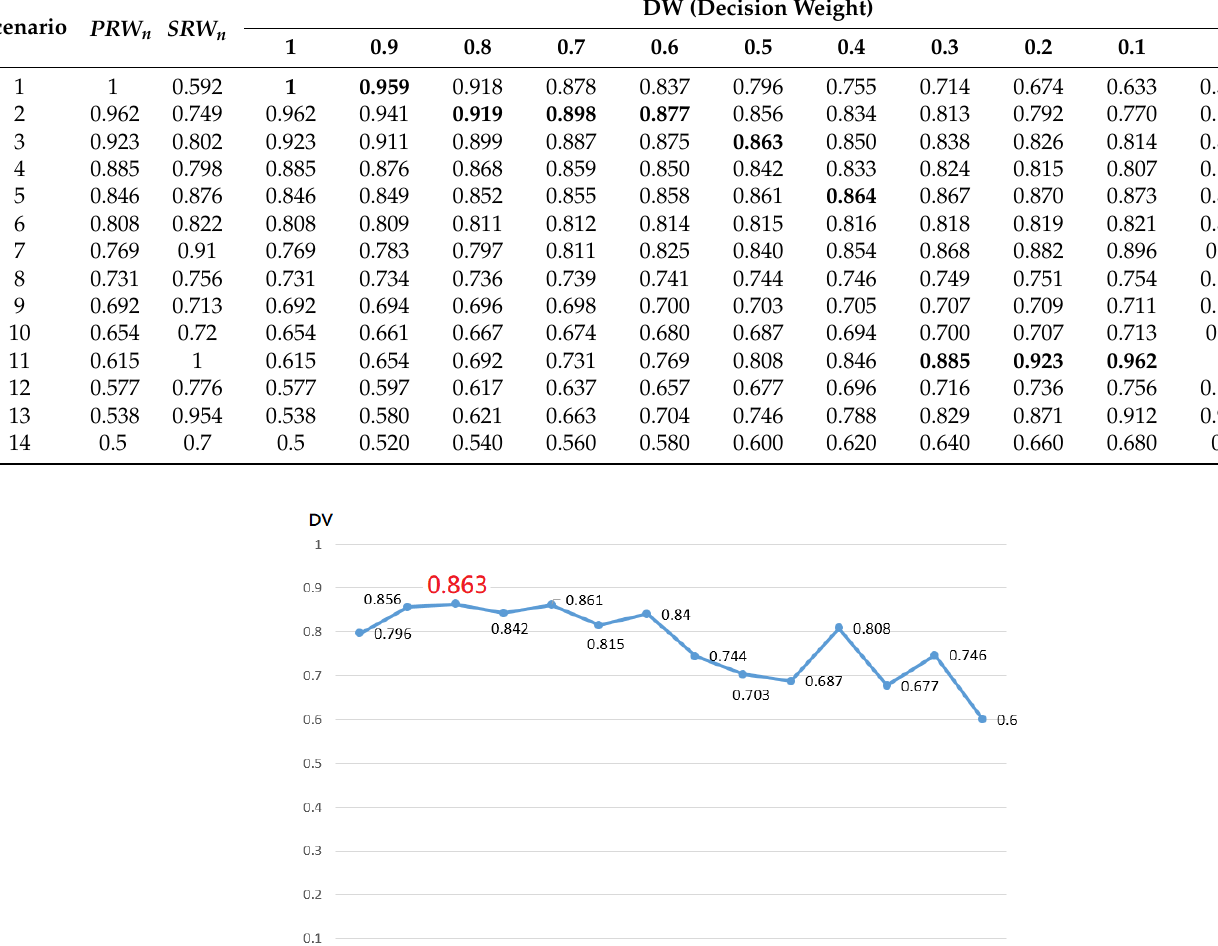
Table 4. Decision values (DV) of scheduling scenarios.